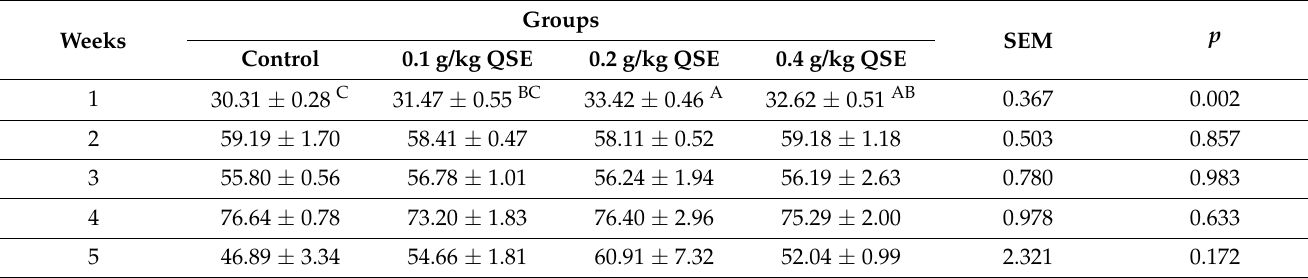
Table 2. Weekly live weight gain values of experimental groups (g).